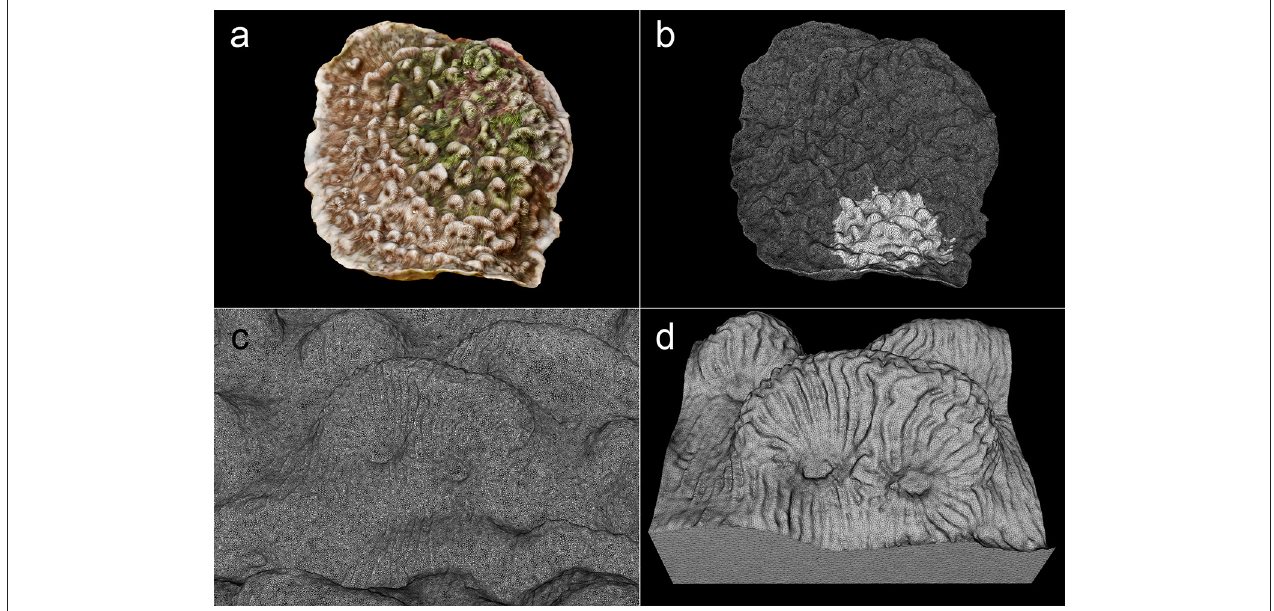
FIGURE 14 | Multi-scale 3D meshes of Leptoseris incrustans colony and corallites. (a) 3D model of colony with texture mapping. (b) 3D mesh of same colony, note the embedded corallites with higher triangle count on the lower side. (c) Close-up of portion of mesh with higher triangle count corallites. (d) Cropped corallites for 3D